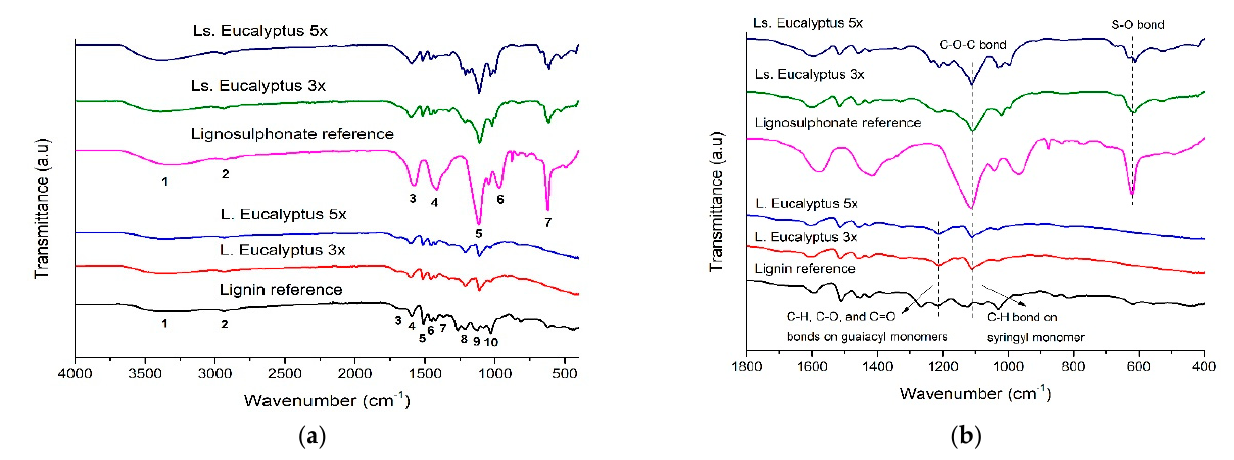
Figure 5. FTIR spectra of lignin and lignosulphonate at: ( a ) wavenumber range of 4000–400 cm − 1 , and ( b ) wavenumber range of 1800–400 cm − 1 .